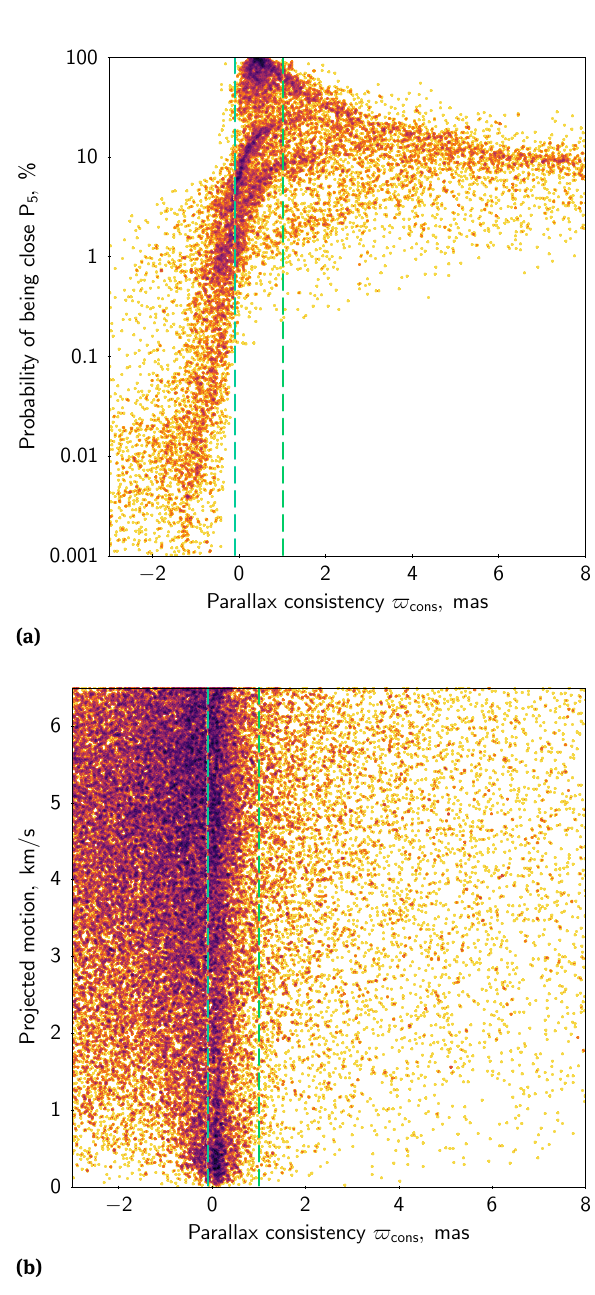
Figure 1. Scatterplots illustrating the parallax consistency ϖ cons = 3( ϵ ϖ + ϵ ϖ ) − | ( ϖ 1 − ϖ 2 ) | selection process on a small sample 1 2 of 65000 pairs formed from real stars random sample with 8pc maximum separation and no limits on parallax consistency. On both scatterplots region of parallax consistency from −0.1 to 1 is shown by vertical dashed lines. On the left: relation between parallax constistency and modelled probability for pair components to be within 5 pc of one another along line of sight (in percent). Scale for probability is logarithmic. On the right: Relation between consistency of parallaxes within errors and relative motion of pair